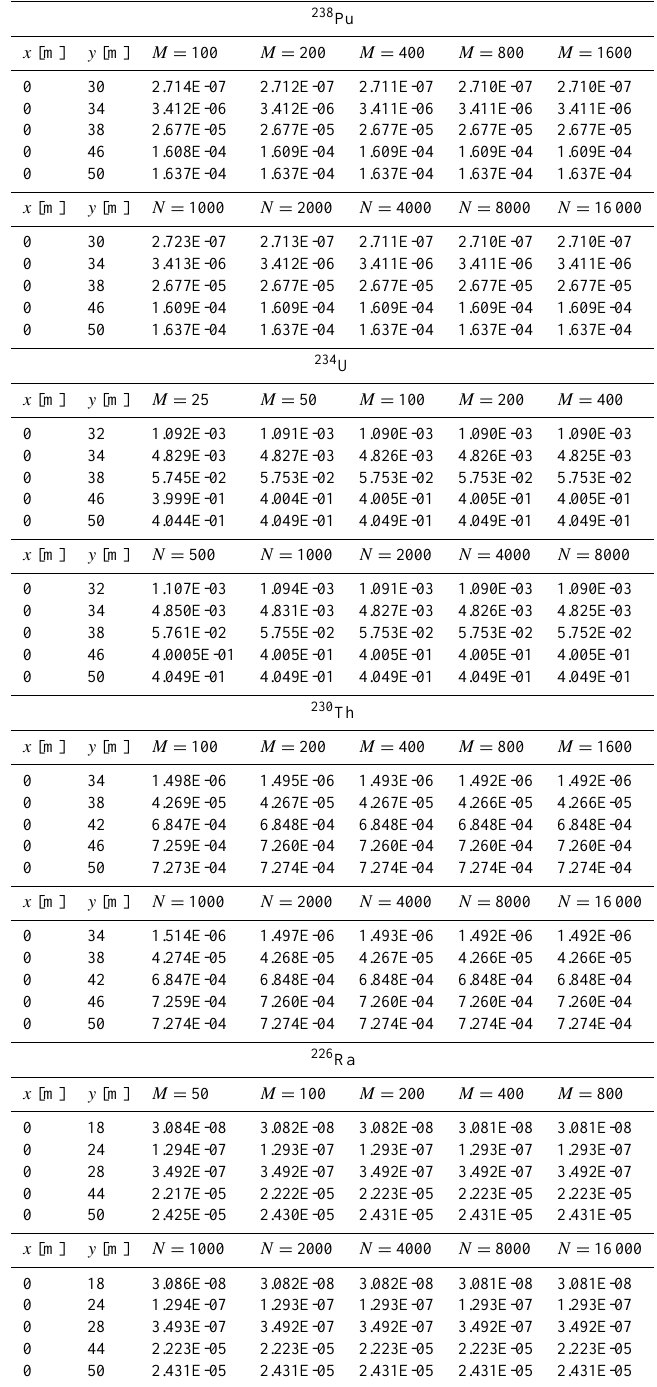
Table 3. Solution convergence of each species concentration at transect of inlet boundary ( x = 0 ) for four-species radionuclide trans- port problem considering simulated domain of L = 250m, W = 100m, subject to Bateman-type sources located at 40m ≤ y ≤ 60m for t = 1000s year ( M = number of terms summed for inverse generalized integral transform; N = number of terms summed for inverse fi- nite Fourier cosine transform). When we investigate the required M for inverse generalized integral transform, N = 16000 for the finite Fourier cosine transform inverse are used. When we investigate the required N for inverse finite Fourier cosine transform, M = 1600 for the generalized transform inverse are